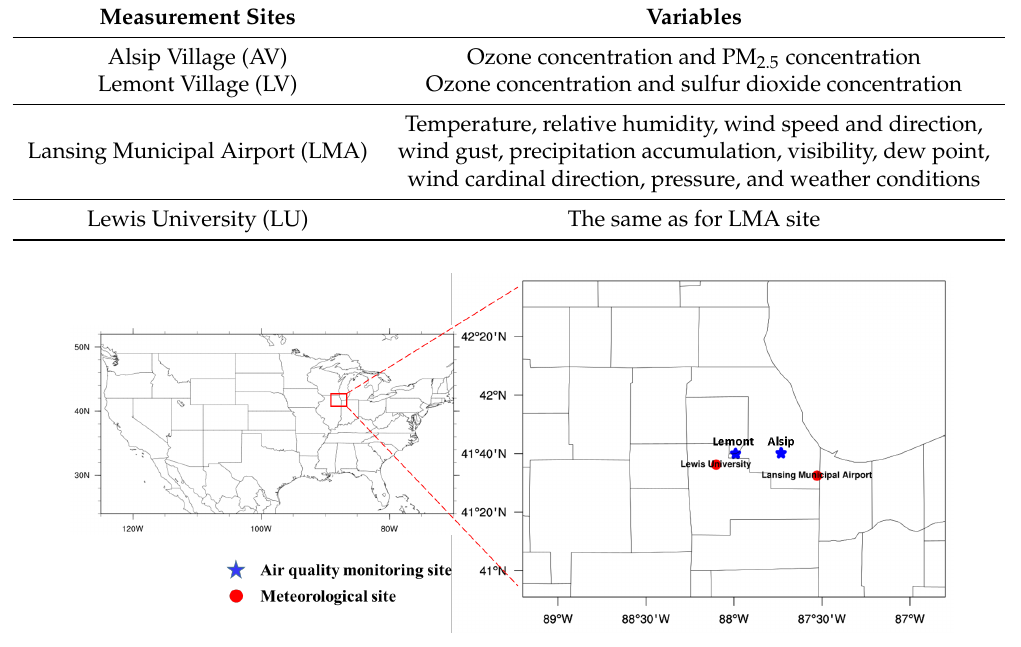
Figure 1. Locations of measurement sites. Blue stars denote the two air quality monitoring sites. Red circles denote the two meteorological